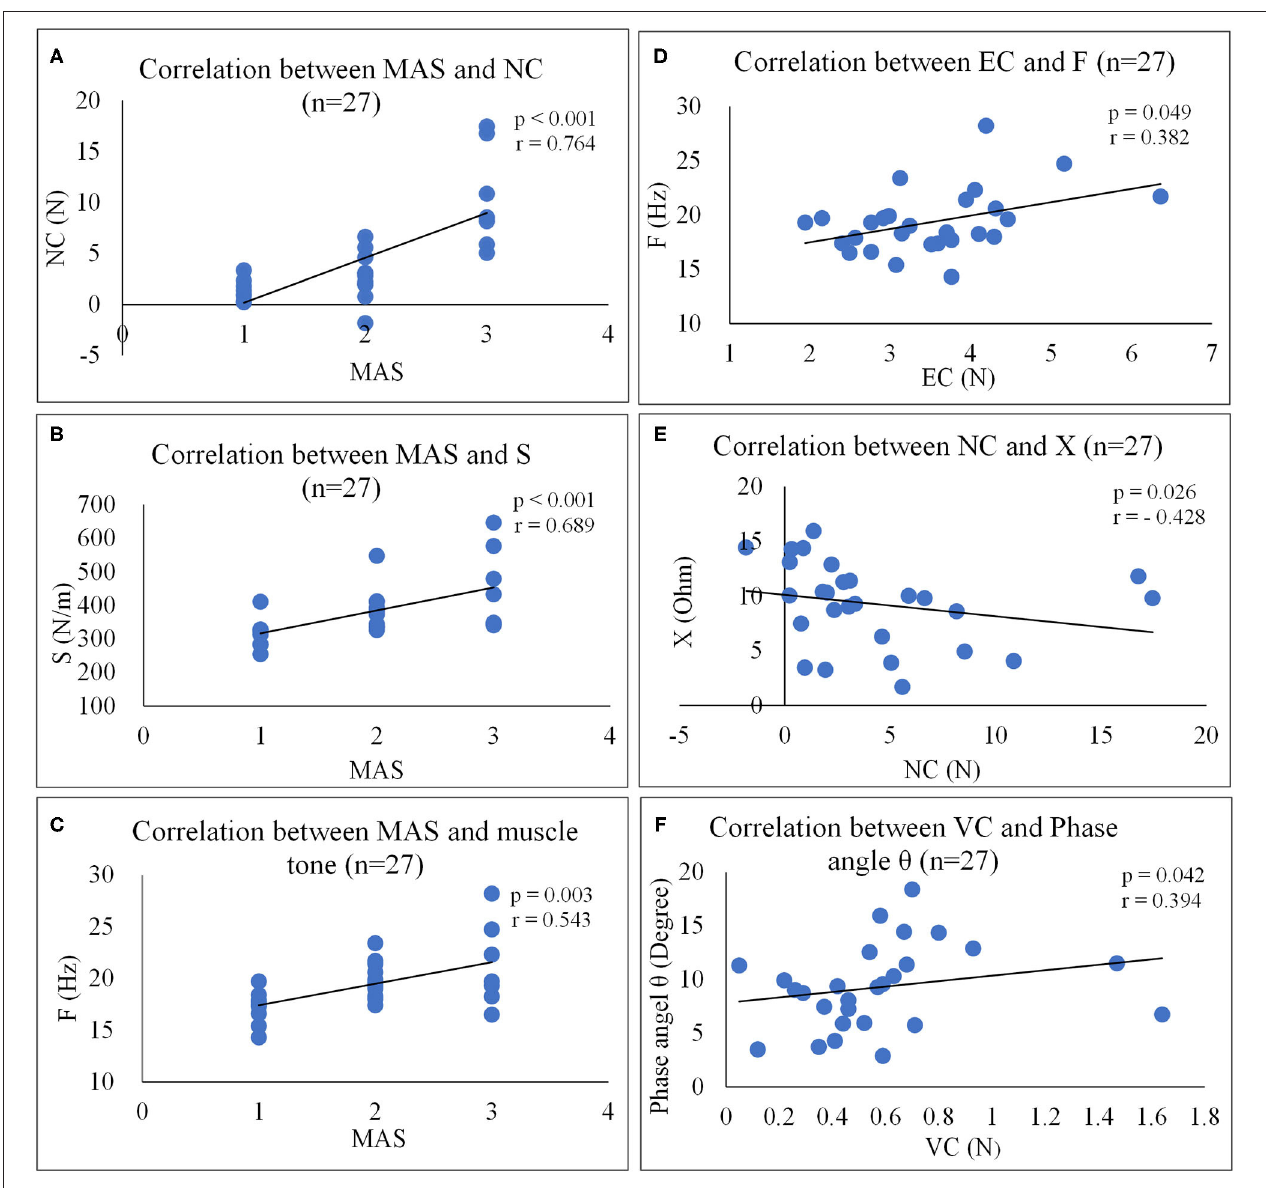
FIGURE 4 | Correlation analyses between outcome measures. (A) Correlation between MAS and NC ( n = 27). (B) Correlation between MAS and S ( n = 27). (C) Correlation between MAS and muscle tone ( n = 27). (D) Correlation between EC and F ( n = 27). (E) Correlation between NC and X ( n = 27). (F) Correlation between VC and phase angle θ ( n = 27). NF, NeuroFlexor; NC, Neural Component; EC, Elasticity Component; VC, Viscosity Component; S, Stiffness; F, Frequency; EIM, Electrical impedance myography; X, Reactance; R,